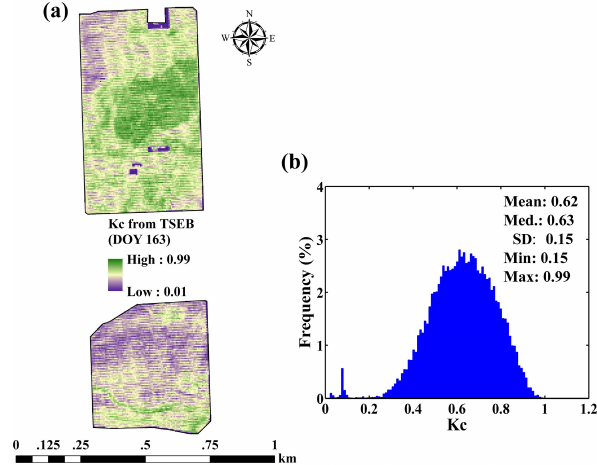
Figure 13. Spatial variation in the crop coefficient K c computed using TSEB output of ET and ET 0 computed from FAO56 for DOY 163 imagery (a) . The frequency distribution in K c for the im- age is illustrated (b)